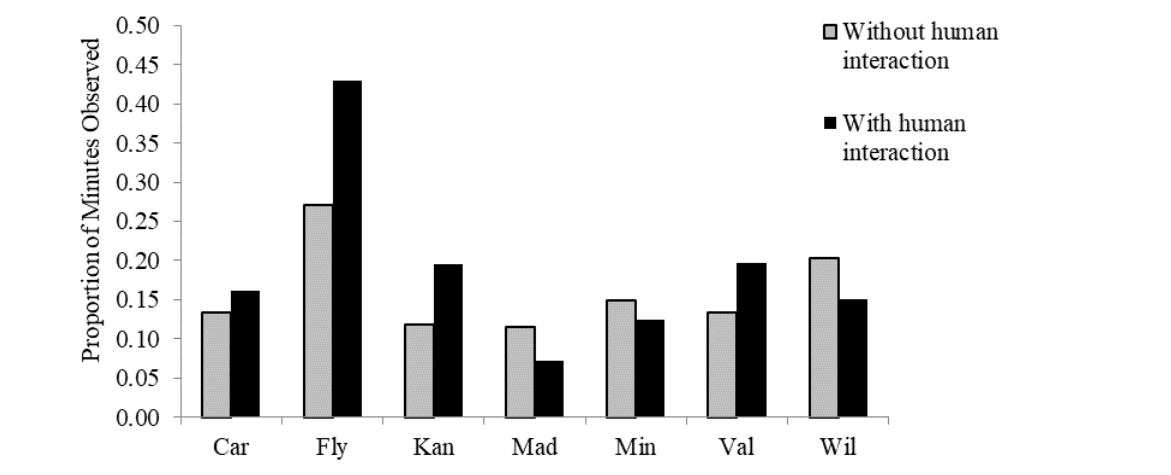
Prevalence of Self-maintenance Behavior with and without human interaction